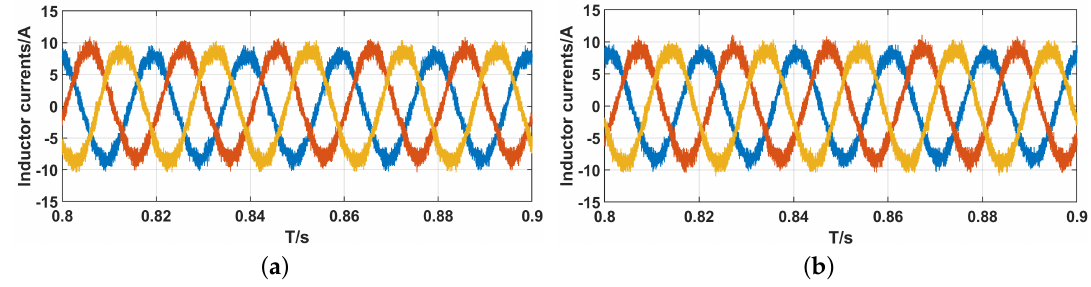
Figure 9. Inductor currents of both controllers. ( a ) PI-based DPC; ( b ) ISMC-based DPC.